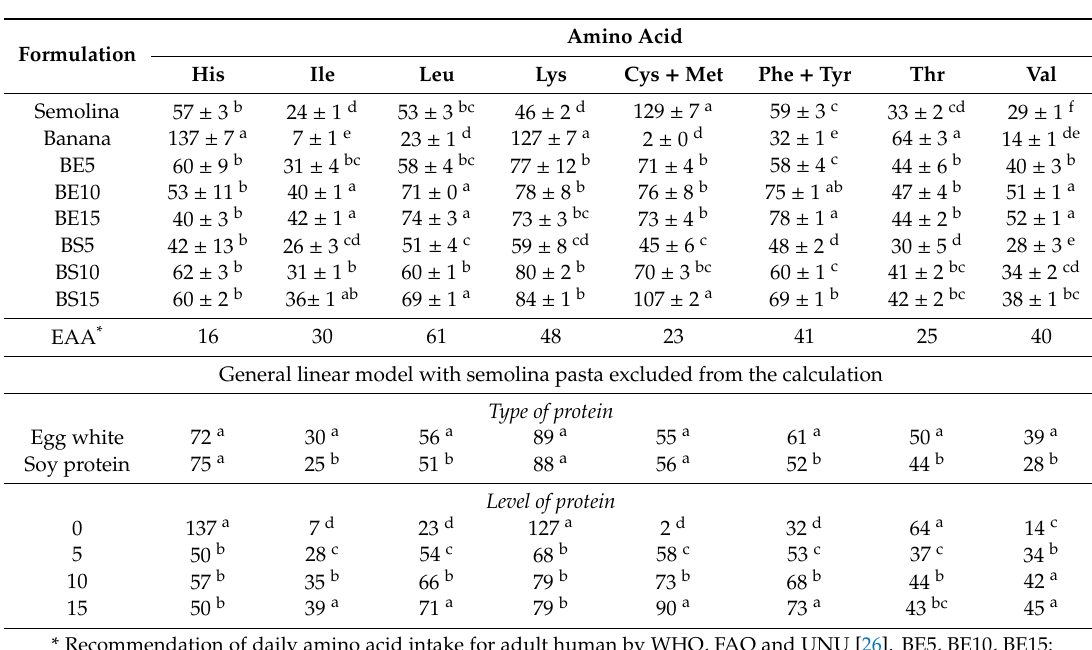
Table 3. Comparison of amino acid profiles in samples pasta with daily adult intake recommendation (mg of amino acid per g